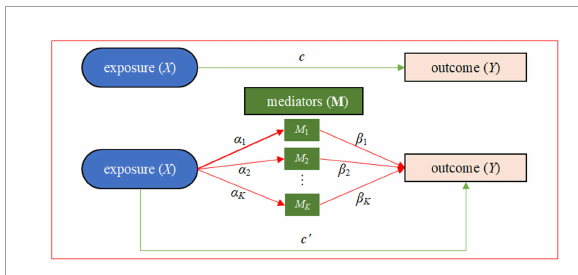
FIGURE1 Statistical framework of the gene-centric mediation analysis with one exposure X (e.g., childhood maltreatment), multiple DNA methylation mediators M, and one outcome Y (e.g., PTSD). Here, α = ( α ... , α 1 , K ) is the vector of effect sizes of the exposure on K mediators in the exposure-mediator model, β = ( β 1 , ... , β K ) is the vector of effect sizes of the K mediators on the outcome in the mediator-outcome model, c (cid:48) is the direct effect conditional on the mediators, and c is the total exposure on outcome effect. There are two types of effects from X to Y : the direct effect of X on Y (i.e., c (cid:48) ) and the indirect effect of X on Y via the intermediate variables M. The indirect effect, also known as mediation effect denoted by αβ , represents the amount of mediation coming from two sources: the effect from X to M (i.e., α ) and the effect from M to Y (i.e., β ).